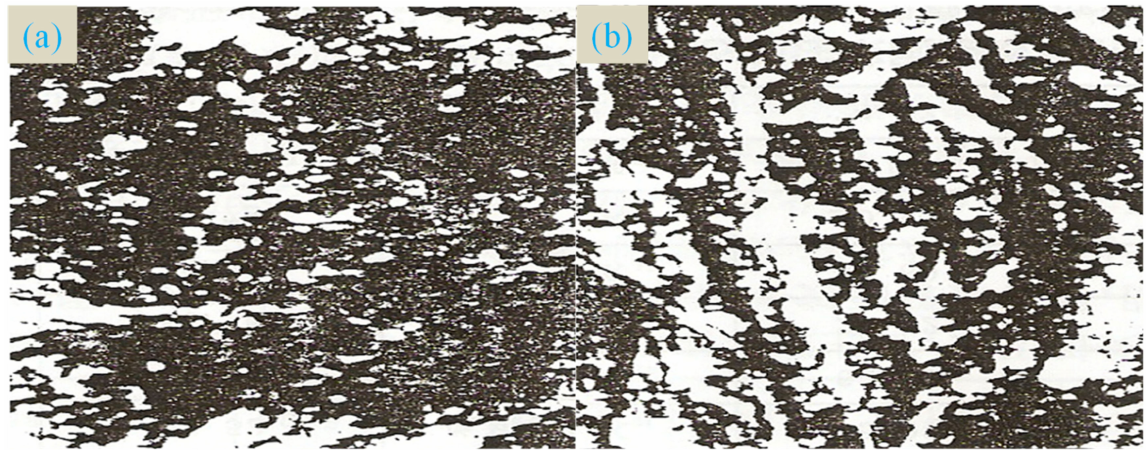
Figure 3. Electron microscopy of coal before and after pressure grouting: ( a ) before, ( b )